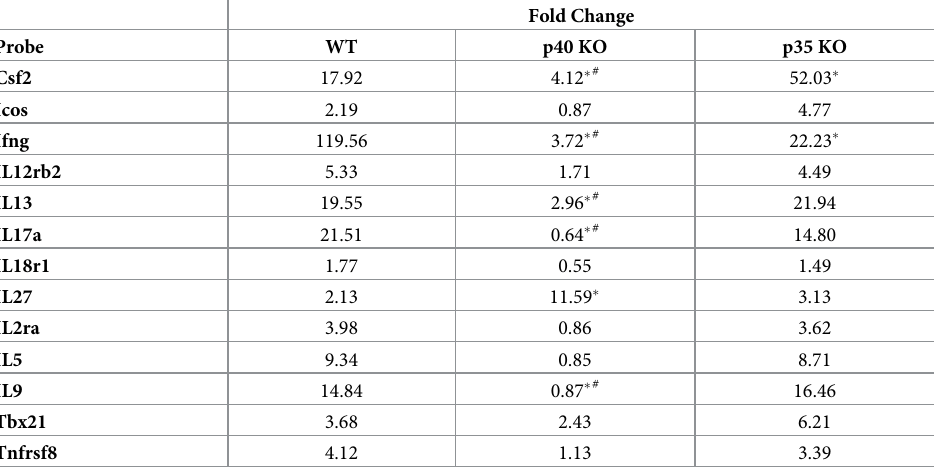
Splenocytes from 3–4 na ï ve mice or mice vaccinated with 10 5 LVS i.d., were co-cultured with LVS-infected BMDMs from the same genotype. Splenocytes were collected from co-culture two days after infection and used to purify RNA. Gene expression was analyzed by RT-PCR using probes against a panel of 84 inflammatory cytokine and chemokine genes. Genes shown were significantly different between WT and KO splenocytes and/or displayed a pattern of higher expression in WT and p35 KO splenocytes versus p40 KO splenocytes. Values shown are represented as fold changes over genotype-matched na ï ve samples. Data are the average fold changes from three independent experiments. Mice used were ages 3–9 months and were aged matched within each experiment. � p < 0.05 between KO and WT # p < 0.05 between p40 KO and p35 KO by ANOVA with Tukey’s multiple comparisons test.